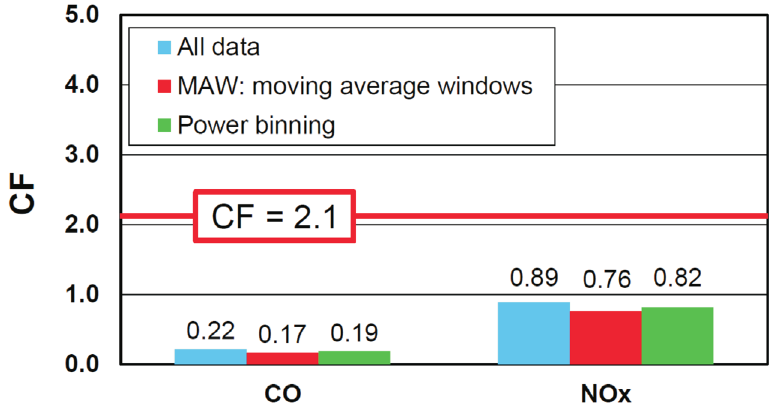
13. Conformity factors of carbon monoxide and nitrogen oxides emissions from tests em - ploying different methods of processing results (gasoline